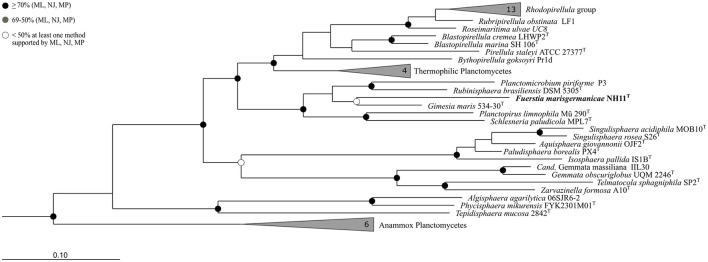
Phylogeny of strain NH11T. A maximum-likelihood 16S rRNA gene based tree of the phylogenetic position of strain NH11T. Strain NH11T is highlighted in bold letters and in comparison planctomycetal type strains are shown, while selected Verrucomicrobia served as outgroup. The bootstrap percentages of 1000 resamplings of three different tree building methods (ML, Maximum Likelihood; NJ, Neighbor Joining; MP, Maximum Parsimony) are incorporated in this tree, indicated by different shaded dots. Black dots indicate support values above 70% for all three methods while white dots refer to a bootstrap support below 50% for at least one method. Branches that were not supported by all three methods show no dot.